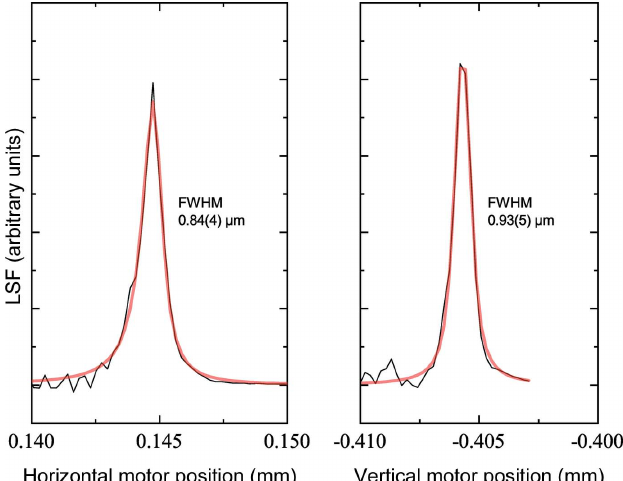
Figure 4 First-order derivatives of sharp-edge scans (LSF) collected during (left) horizontal and (right) vertical motor movement. The FWHM is shown together with the corresponding error bar estimates.